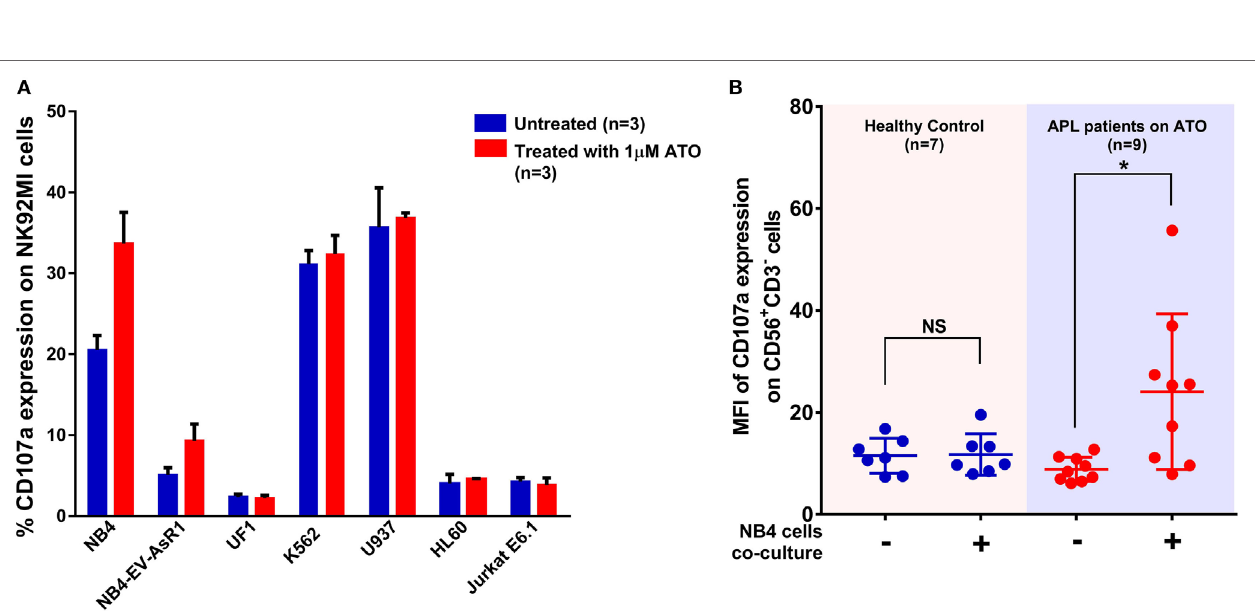
of 2:1 ( n = 3), the mean percentage of CD107a with NB4 cell line without ATO treatment was 20.4 ± 1.8% at the end of 5 h.